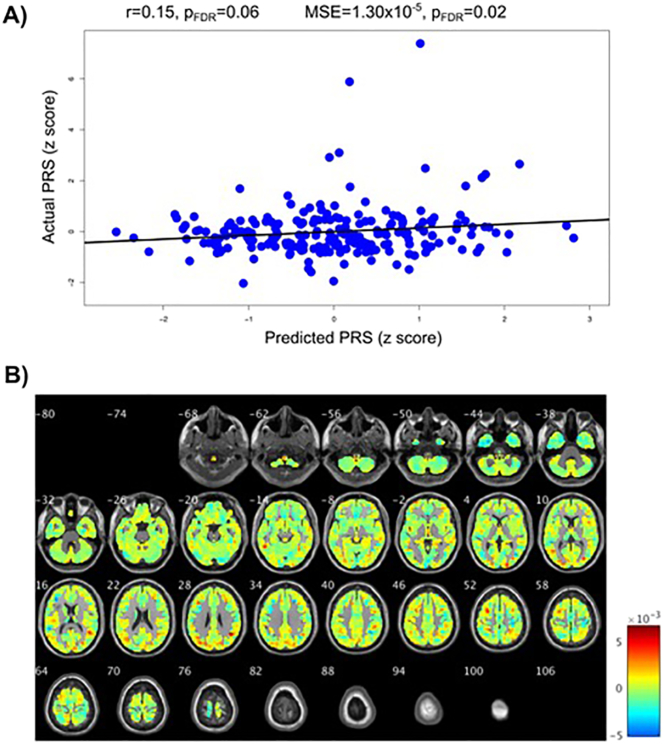
Results for the schizophrenia polygenic risk score (PRS). A) Correlations between actual schizophrenia PRS and the PRS predicted from grey matter volume maps. pFDR = False Discover Rate corrected p-values. B) Weight maps of contribution of voxels across the whole brain for the predicted schizophrenia PRS shown in A (in the whole sample, N = 213).